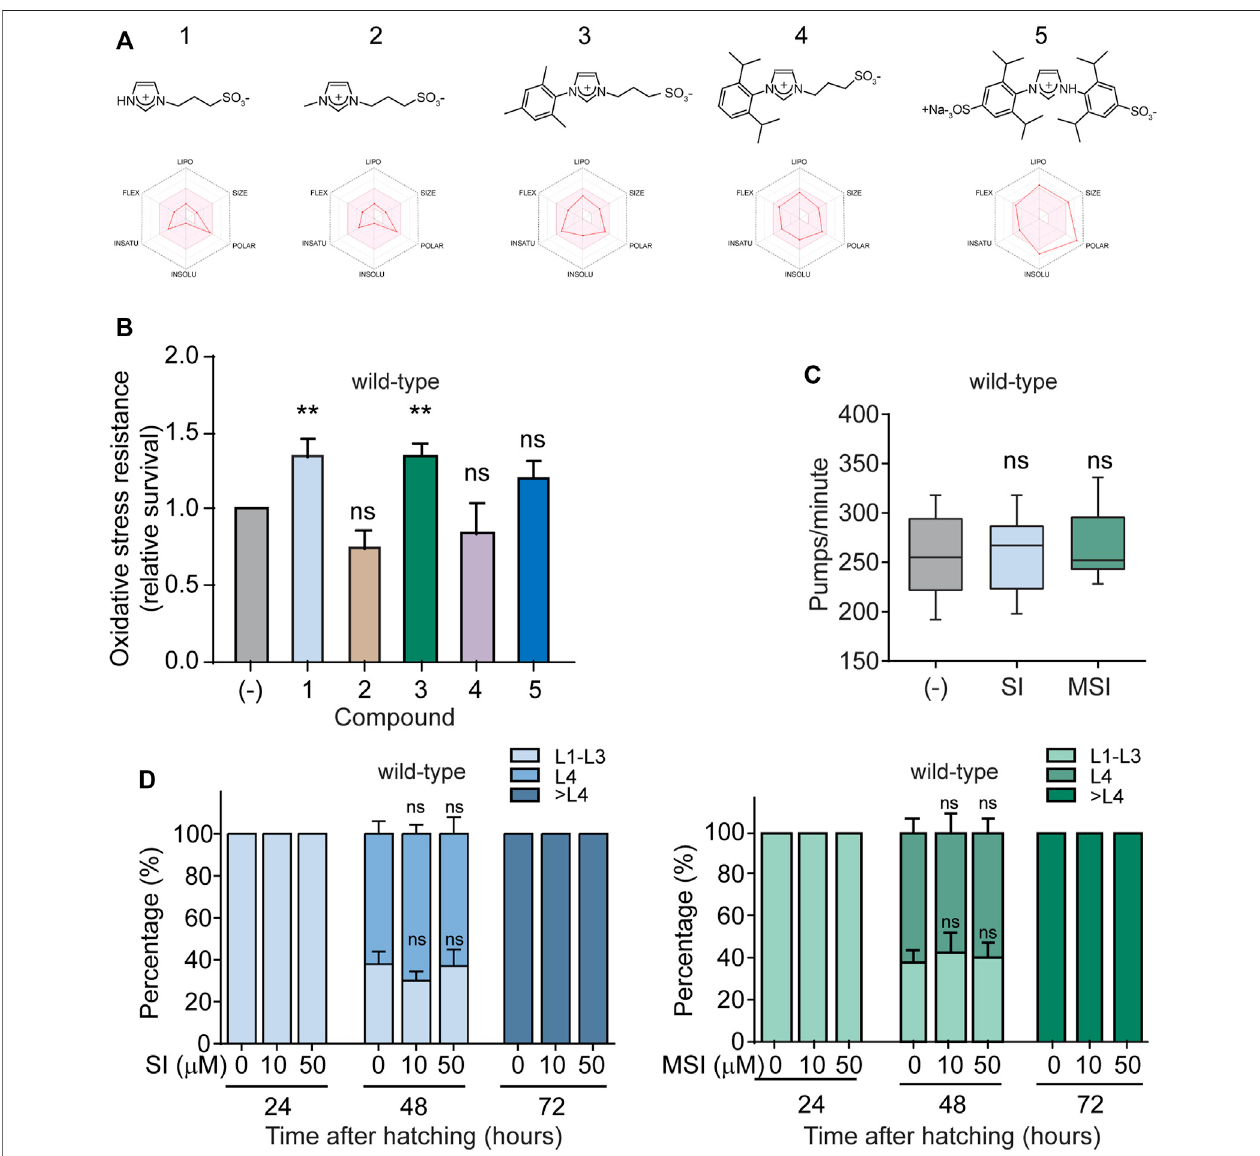
FIGURE1| Effect ofimidazolium salts onoxidativestressresistancein wild-type C.elegans . (A) .Chemical structuresofimidazolium saltswiththeircorresponding oral bioavailability radar below. The pink area represents the optimal range for each property. Compounds 1: 1-(3-sulfonatopropyl) imidazolium, 2: 1-Methyl-3-(3- sulfonatopropyl) imidazolium, 3: 1-Mesityl-3-(3-sulfonatopropyl) imidazolium, 4: 1-(2,6-Diisopropylphenyl)-3-(3-sulfonatopropyl) imidazolium and 5:1,3-bis(2,6- diisopropyl-4-sodiumsulfonatophenyl)imidazolium. (B) .Oxidativestressresistanceofwild-typewormsintheabsence(-)orpresenceof10 μ Mofeachimidazolium salt(60 – 80animalsperconditionper experiment, n =3 – 8).Oxidativestresswasinducedby10 mMFeSO4for1 h.Survivalwasscoredimmediatelyafter thistreatment. Data are normalized to the resistance of wild-type animals in the absence of compound assayed the same day. Data in the bar graph are represented as mean ± SEM. Statistical signi fi cance was evaluated by One-way ANOVA followed by Holm – Sidak ’ s test for multiple comparisons against the control group (-) (** p < 0.01). (C) . Pharyngealpumpingrates(pumpspermin)ofwild-typewormsintheabsence(-)orpresenceof10 μ MofSIandMSI(30animalspercondition).Dataisrepresentedasa boxplotwithalineatthemedian.StatisticalanalysisofthedatawasperformedwithaKruskal – Wallisone-wayANOVAonranks.Nostatisticaldifferences(ns)compared towormswithoutcompoundtreatment(-). (D) .Developmentalrateofwild-typewormsgrownintheabsence(-)orpresenceof10and50 μ MofSI(left)andMSI(right).A color code was used to represent each of the following animal stages: L1 – L3: early larval stages, L4: last larval stage, > L4: adult stage. Animal classi fi cation was evaluatedattheindicatedtimepoints(24,48,and72 h).Dataarerepresentedinastackedbarchartasmean±SEM.Nostatisticaldifferences(ns)werefoundcompared to worms without compound treatment (-) (One-way ANOVA for MSI and One-way ANOVA on ranks for SI, n = 4 independent experiments).